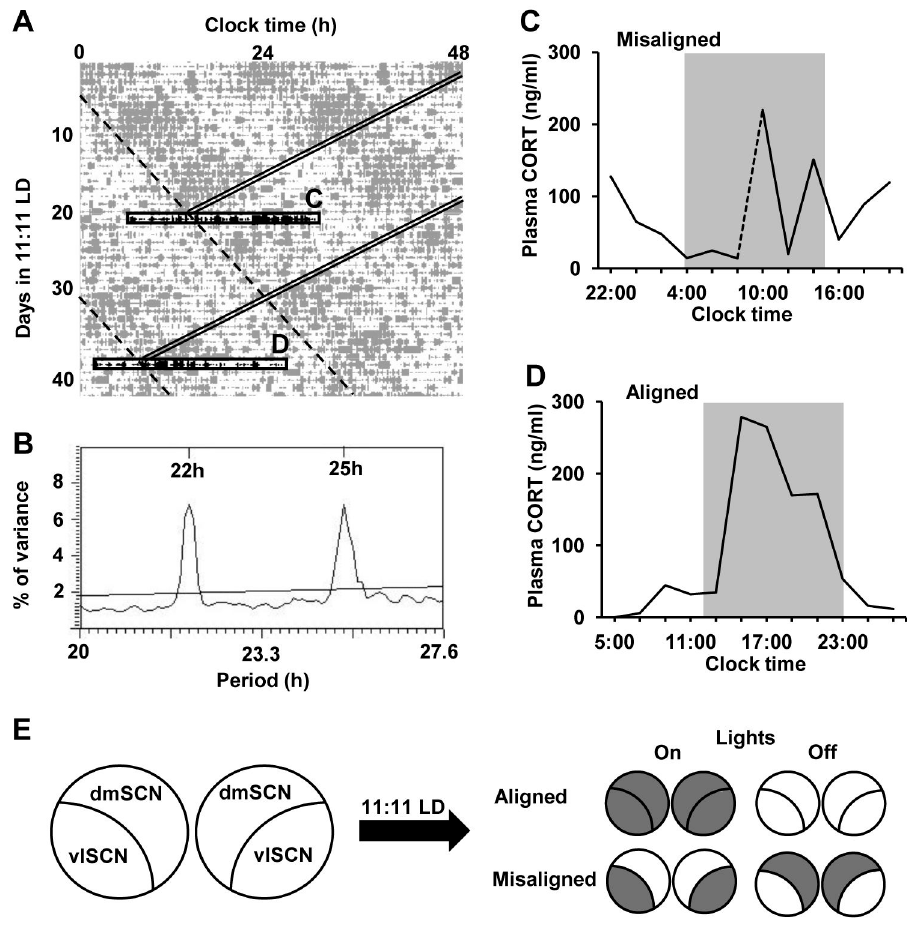
Figure 1. Forced desynchrony disrupts the plasma corticosterone rhythm. A) Double-plotted locomotor activity of a representative forced desynchronized rat. Grey bars represent locomotor activity; double diagonal bands indicate the time of lights- on ( for box “C” ) or time of lights-off ( for box “D” ); dashed diagonal lines indicate the onset of dmSCN-associated locomotor activity bout with the angle set to match the LD-dissociated period indicated in the periodogram (B); black horizontal boxes indicate the 24-h periods during which blood samples were taken every two hours during misaligned ( top, “C” ) or aligned ( bottom, “D” ) phases. B) The X 2 periodogram analysis of locomotor activity revealing two statistically significant rhythmic components (22 h and 25 h) in the animal shown in (A). C and D) The plasma corticosterone profiles (raw data) determined for the one animal shown in (A) during the days of misalignment and alignment, respectively. The dotted line in (C) represents predicted values between initial (t = 10: 00) and final (t = 8: 00) sampling times. Grey shading indicates time of lights off. E) Schematic diagram of predicted Per1 expression patterns in the subregions of the SCN at 5.5 h after lights-on or lights-off on days of alignment and misalignment. Predicted Per1 expression patterns (grey and white for high and low expression, respectively) are based on previous studies [20,22,28].